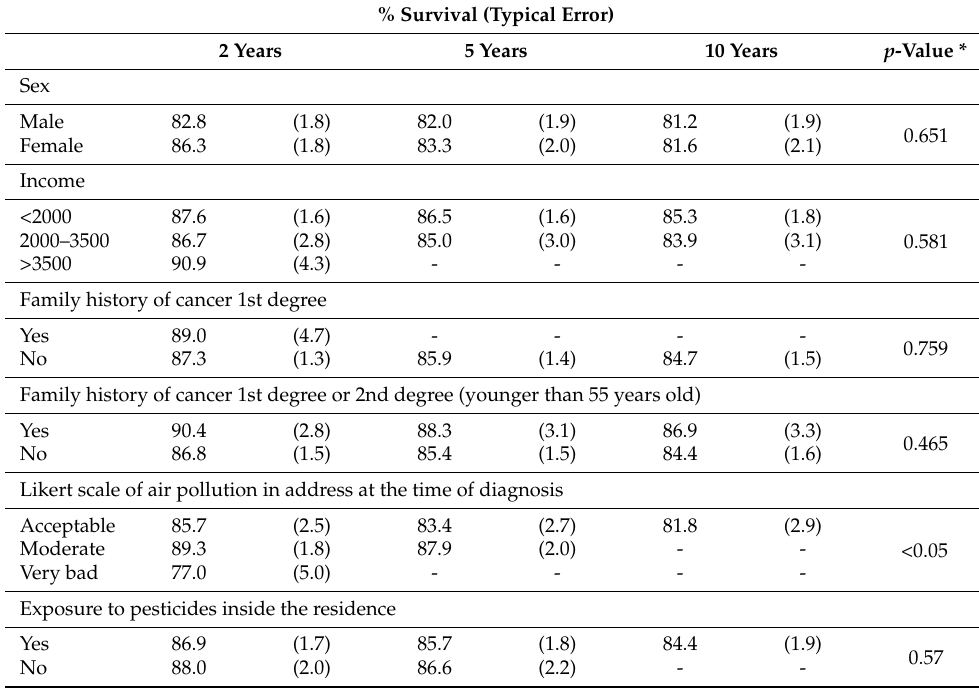
Figure 2. Cumulative survival per year of survival of the three groups of the Likert scale for air pollution in the region of Murcia (1998–2020). Table 2. Childhood cancer survival at 2, 5, and 10 years by distribution for the individual and socioeconomic characteristics and environmental exposure in the region of Murcia